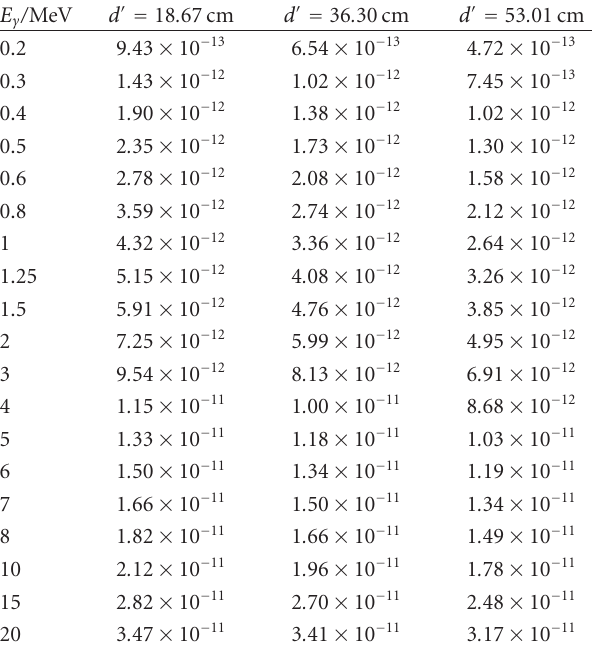
Table 1: X-ray fluence-to-mean-dose conversion factors for mono- energetic broad parallel beams incident on 18.67, 36.30, and 53.01 cm thick water slabs in air in units of Gy/(X-ray/cm 2 ). Statistical uncertainties for each X-ray energy are 1.2%, 1.3%, and 1.3% for the 18.67, 36.30, and 53.01 cm thick water slabs, respectively.